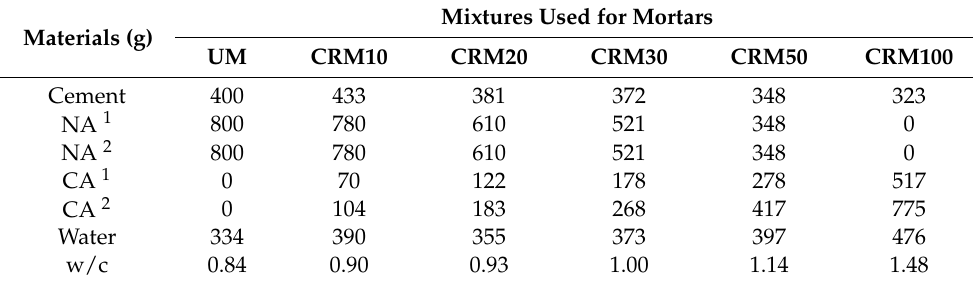
Table 2. Dosage of the study